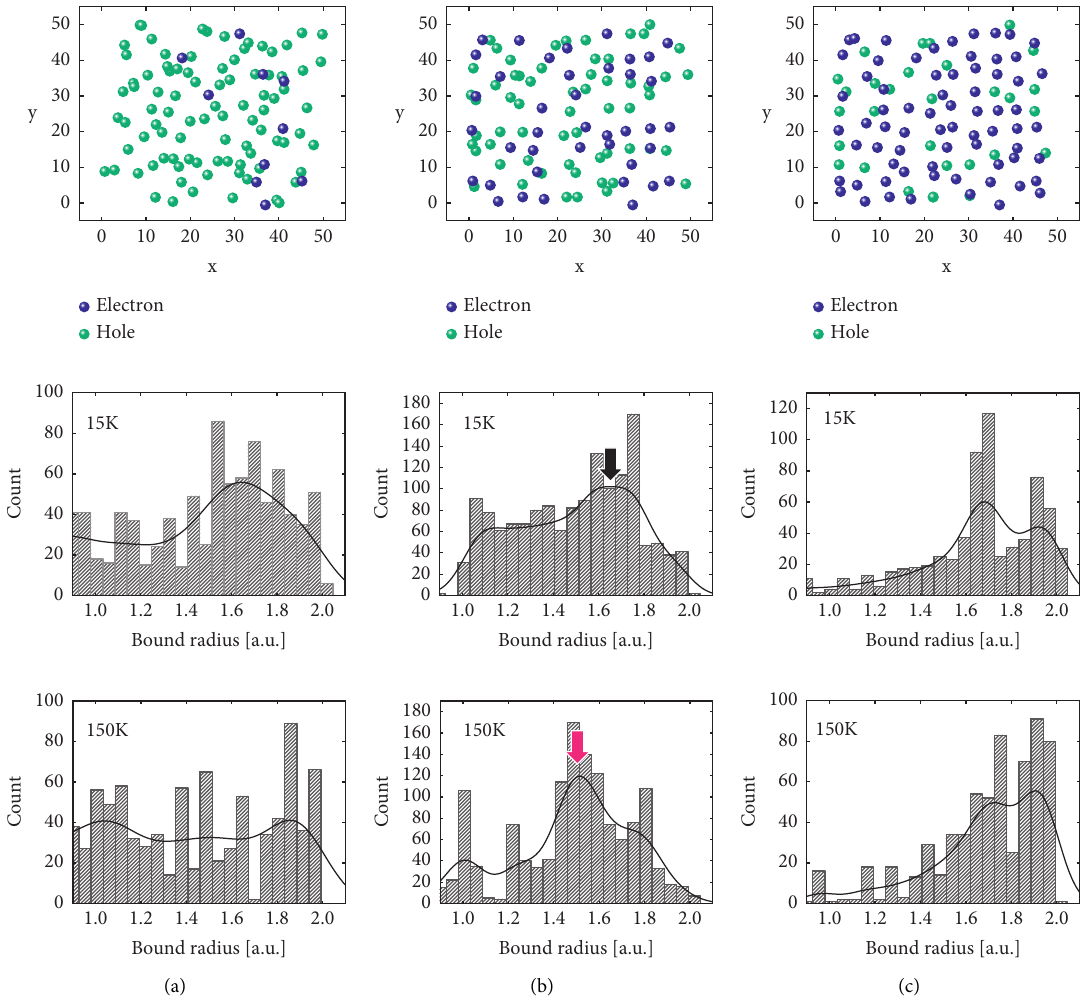
Figure 7: Simulation results of hybrid of Adiabatic quantum annealing simulator with Metropolis-adjusted stochastic gradient Langevin dynamics under different ratio of the number of electrons to the number of holes: (a) ratio of electron/hole is 1: 9; (b) ratio of electron/hole is 4: 6; and (c) ratio of electron/hole is 7:3. The results performed at 15K and 150K are presented for better